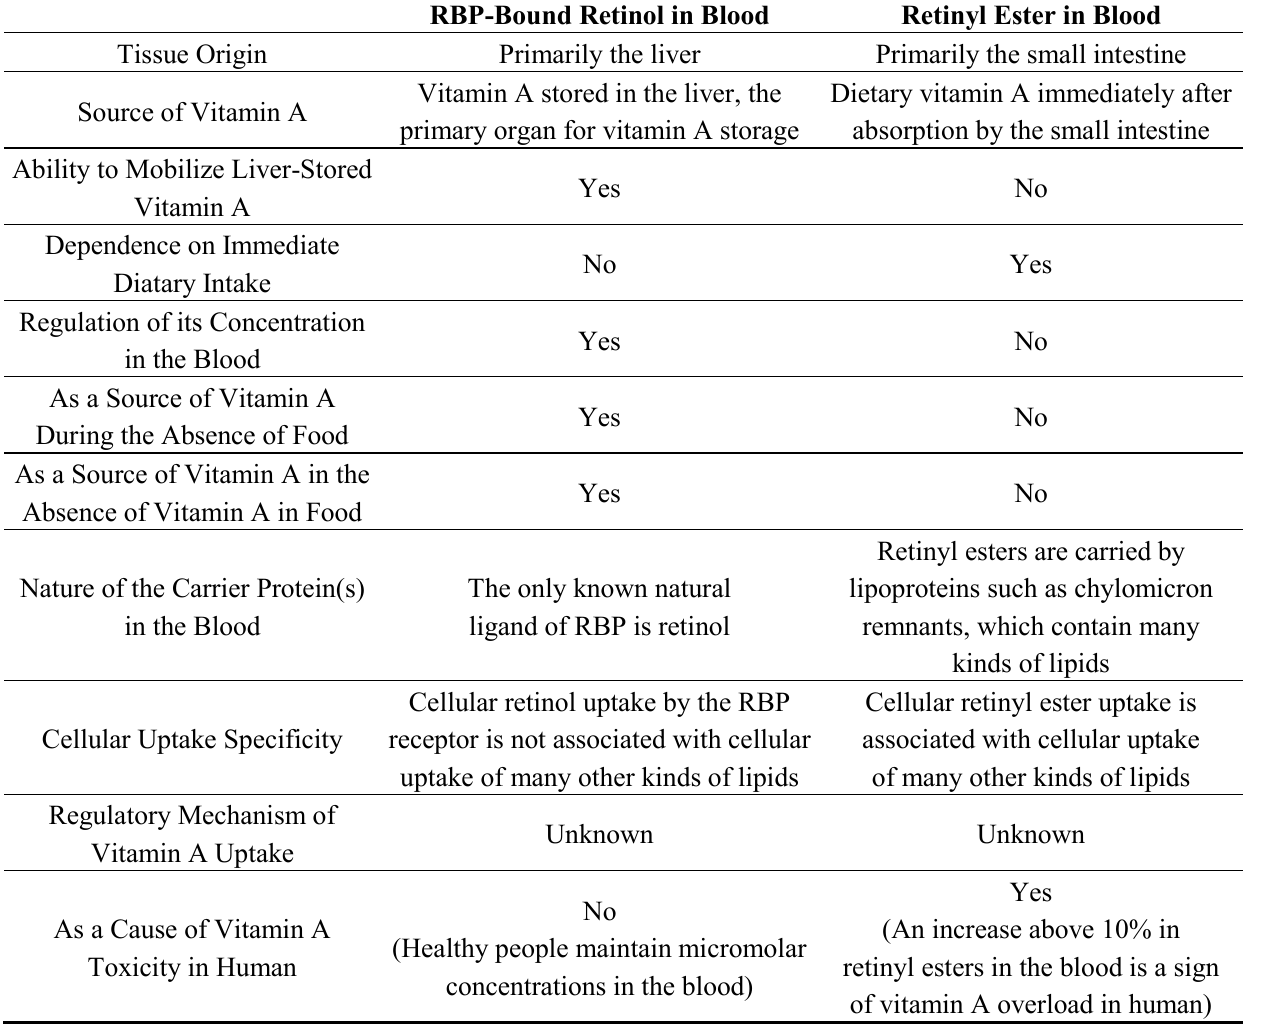
Table 5. Comparison of vitamin A transport via holo-RBP in the blood vs. retinyl esters in the